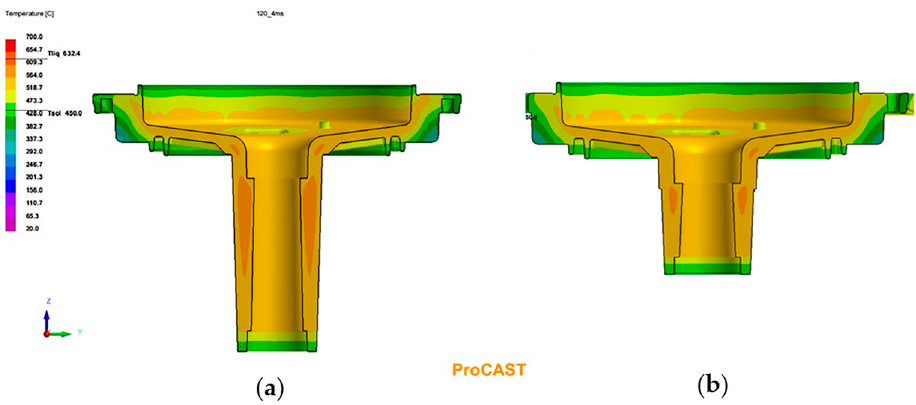
Figure 5. Melt solidification simulation showing hot spots: ( a ) SB 120, ( b ) SB 55. The results of the microporosity simulation correspond with the result of the temperature simulation (Figure 6). In the thickest section of the tube part, the highest presence of microporosity was predicted. Similarly, microporosity was predicted in the thicker section of the hat part.